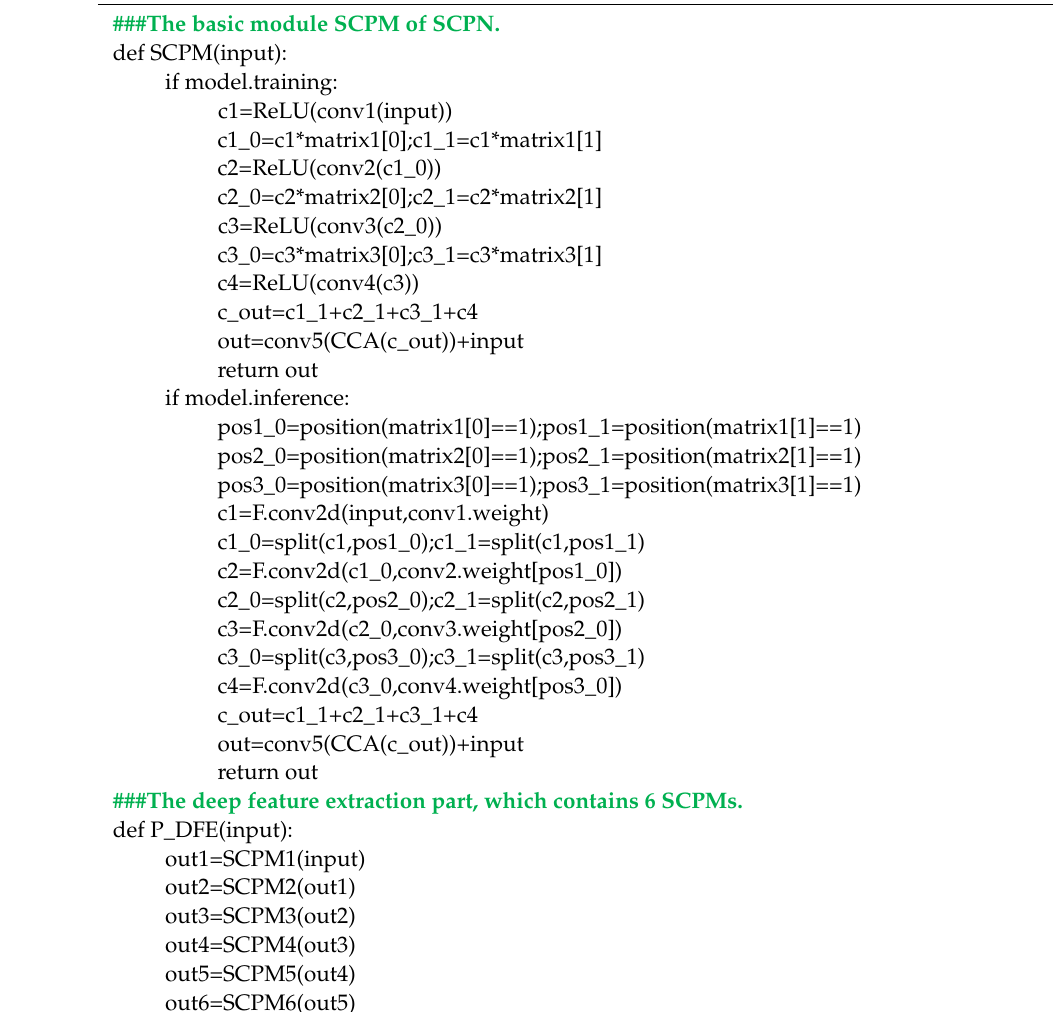
Algorithm 1 The PyTorch-like pseudocode of